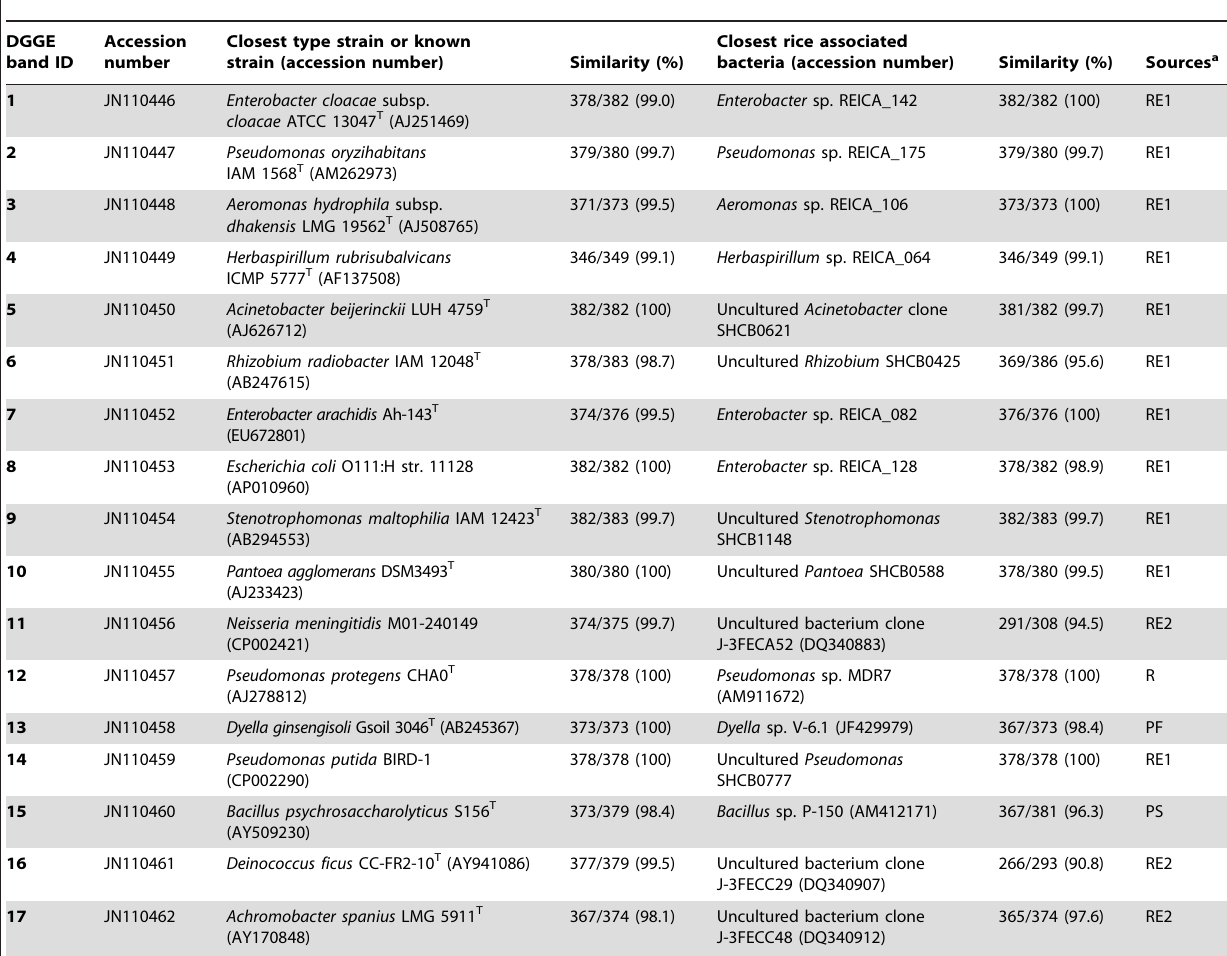
Table 2. Identification of excised PCR-DGGE bands.